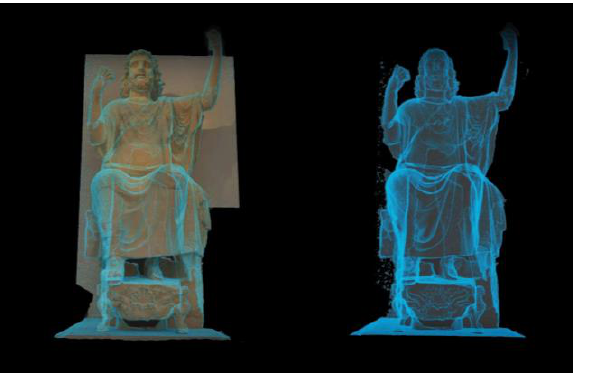
Figure 18. Zeus 3D model